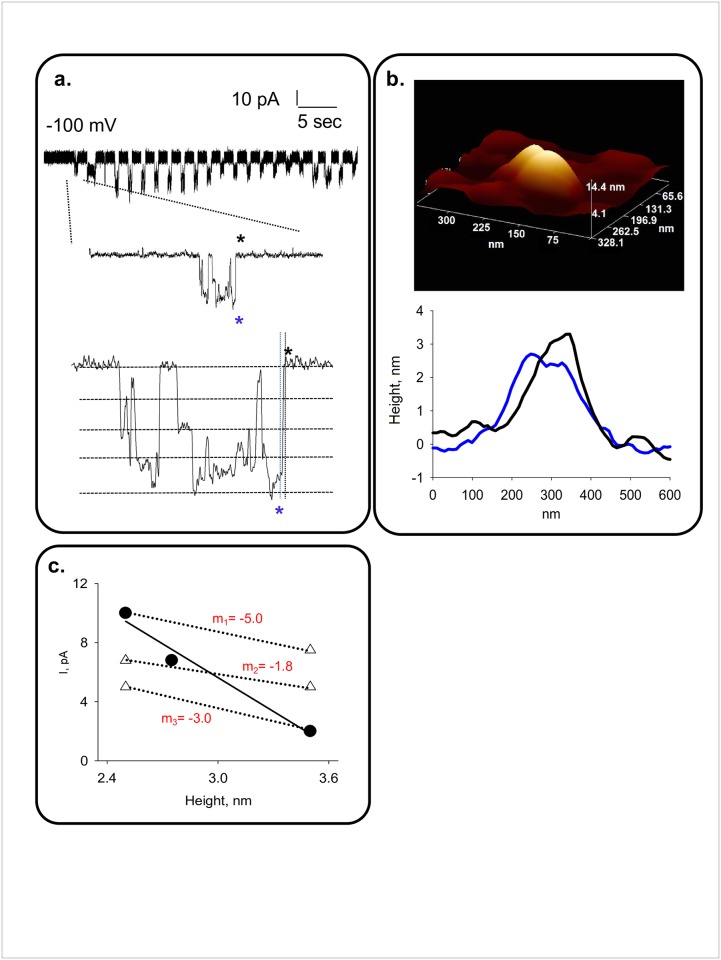
Single channel currents and topological features of PC2.a. Top panel, Unfiltered current tracing of a PC2 channel complex activated by AFM scanning over. The single channel opening selected below is further expanded in the Bottom panel. The expanded tracing shows closed open and states, as well as sub-conductance states (dashed lines). b. Top panel, AFM scanned 3D image of the channel complexes whose activity is shown in panel a. Bottom panel, Single line topological profiles for functional states indicated as Black and Blue asterisks in panel a. Please note that proper correlation depends on synchronization of data acquisition systems c. Negative linear correlation between height and single channel currents for the channel complex (solid line). A 5 msec shift in synchronization would render different measurements (white triangles), and correlations between conductance states, and thus different negative slopes as indicated (dotted lines). (Data representative of n = 5).